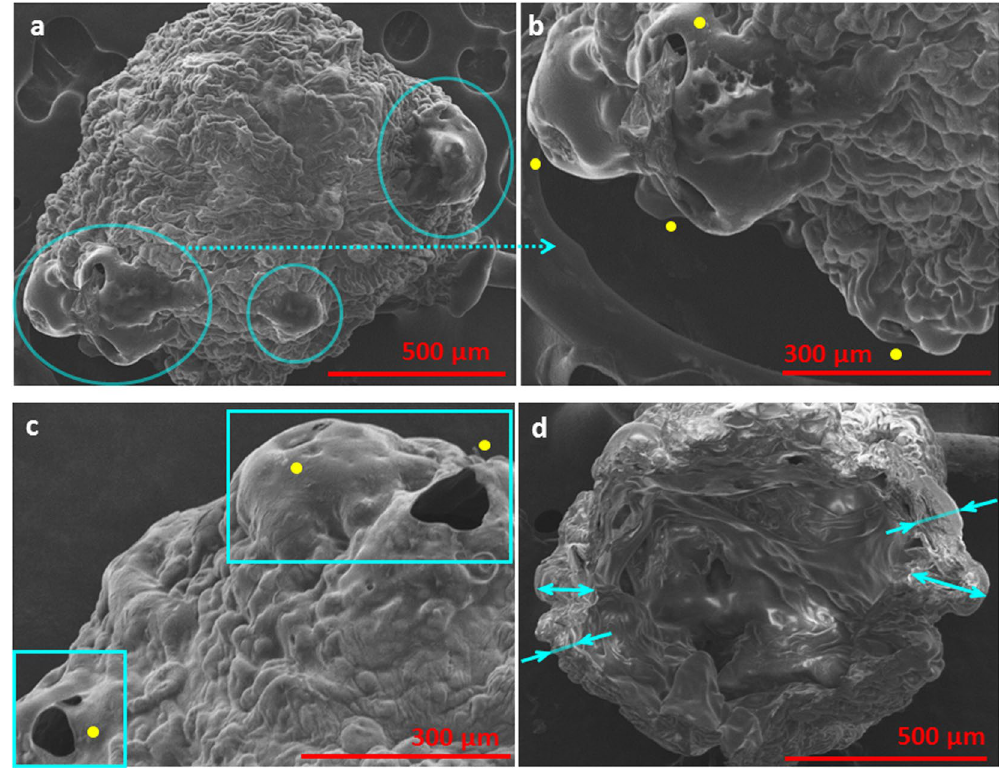
Figure 5. SEM micrographs showing surface morphology of the final combustion residue for a 5 wt.% gelled ethanol fuel droplet: ( a ) Overall view showing a deformed shell structure; blue circles indicate non-uniformly distributed soft regions (preferred rupture sites) with jetting holes, ( b ) magnified view of a soft region showing location of jetting holes (yellow dot markers), ( c ) magnified image demarcating rigid and soft regions of the shell and ( d ) Overall cross-sectional view of final hollow microstructure with non-homogenous shell thickness. This also delineates the smooth inner surface with the rigid outer skin. Magnification for Fig. a–d equals 80X, 150X, 180X and 90X